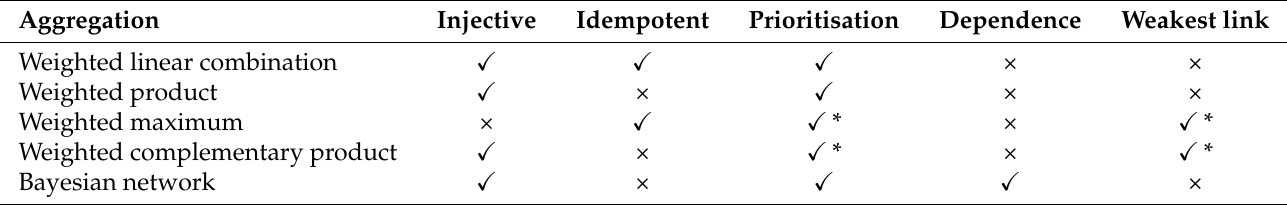
Table 2. Various classes of metric aggregation strategies, and important security-related properties their strategies can possess. Aggregation Injective Idempotent Prioritisation Weighted linear combination Weighted product Weighted maximum Weighted complementary product Bayesian network × * Strategies within the classes of weighted maximum and weighted complementary product cannot satisfy the prioritisation and weakest link properties at the same